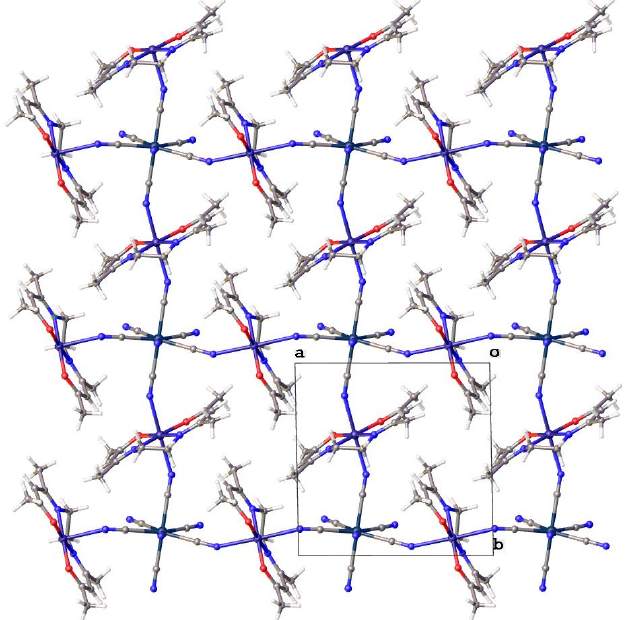
Figure 2. Projection of an anionic layer of 2 along the c -axis, showing a two-dimensional network structure consisting of two different crossed chains.